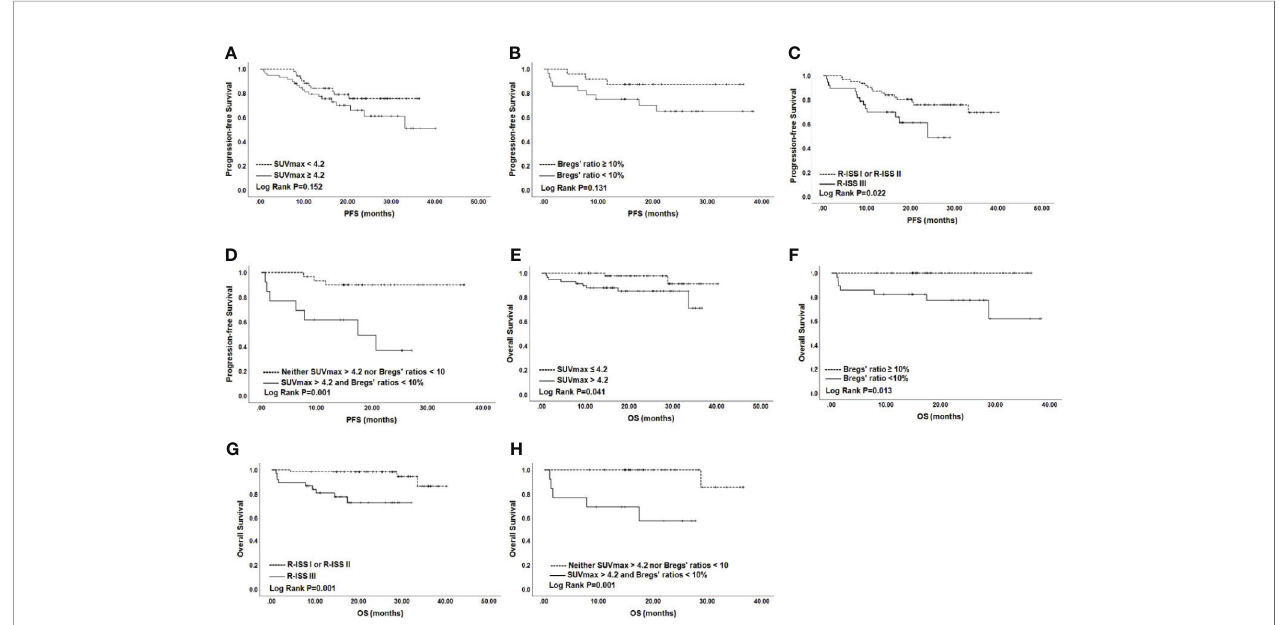
FIGURE 2 | PFS and OS for NDMM patients by SUVmax (A) , Bregs (B) , and R-ISS (C) . OS according to SUVmax (E) , Bregs (F) , and R-ISS (G) . PFS (D) and OS (H) according to SUVmax >4.2 and Bregs ’ ratios <10%. NDMM , newly diagnosed multiple myeloma; PFS , progression-free survival; OS , overall survival; SUVmax , maximum standard uptake value; Bregs , regulatory B cells; R-ISS , Revised International Staging